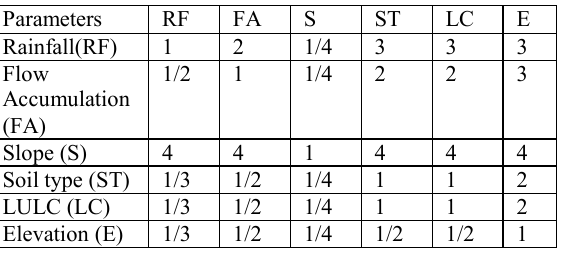
Table 4 Matrix showing the parameters of flood hazard: Analytical Hierarchy Process.